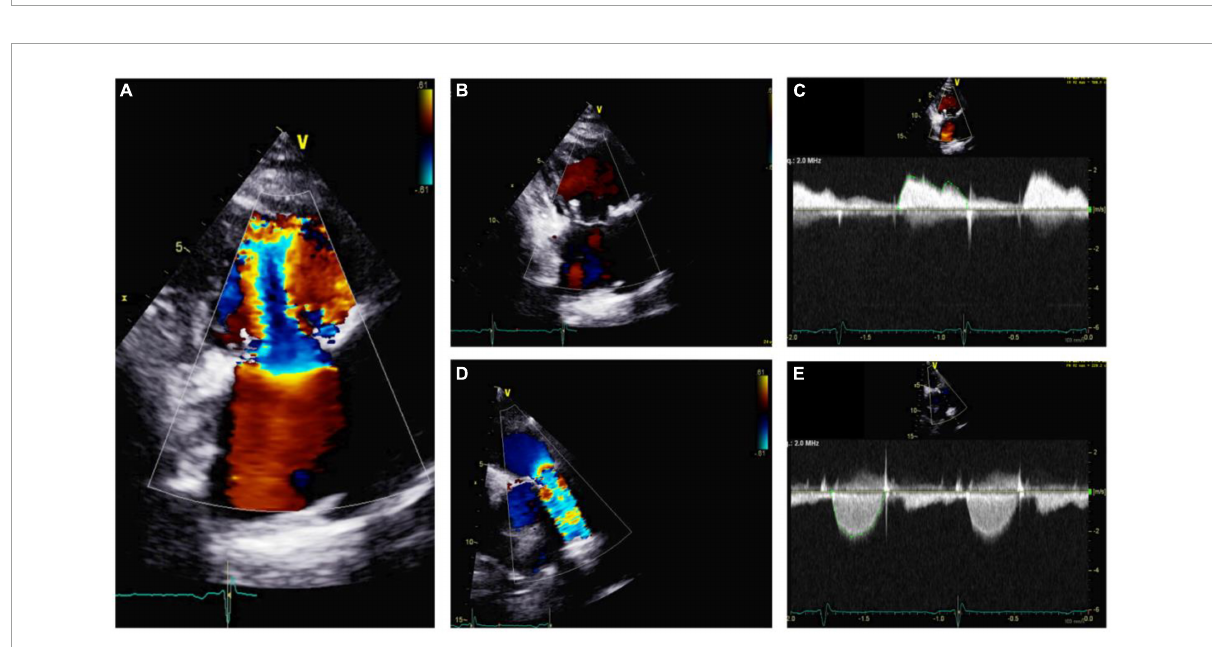
FIGURE7 Echocardiography monitoring in carcinoid heart disease (CnHD): First follow up echo. Tricuspid valve in parasternal long axis showing mild tricuspid stenosis (A) and a lack of tricuspid regurgitation (B) ; continuous wave color Doppler shown (C) . Pulmonic valve is shown in color Doppler (D) and continuous wave color Doppler, where there is evidence of increased pulmonary valve velocity (E) .